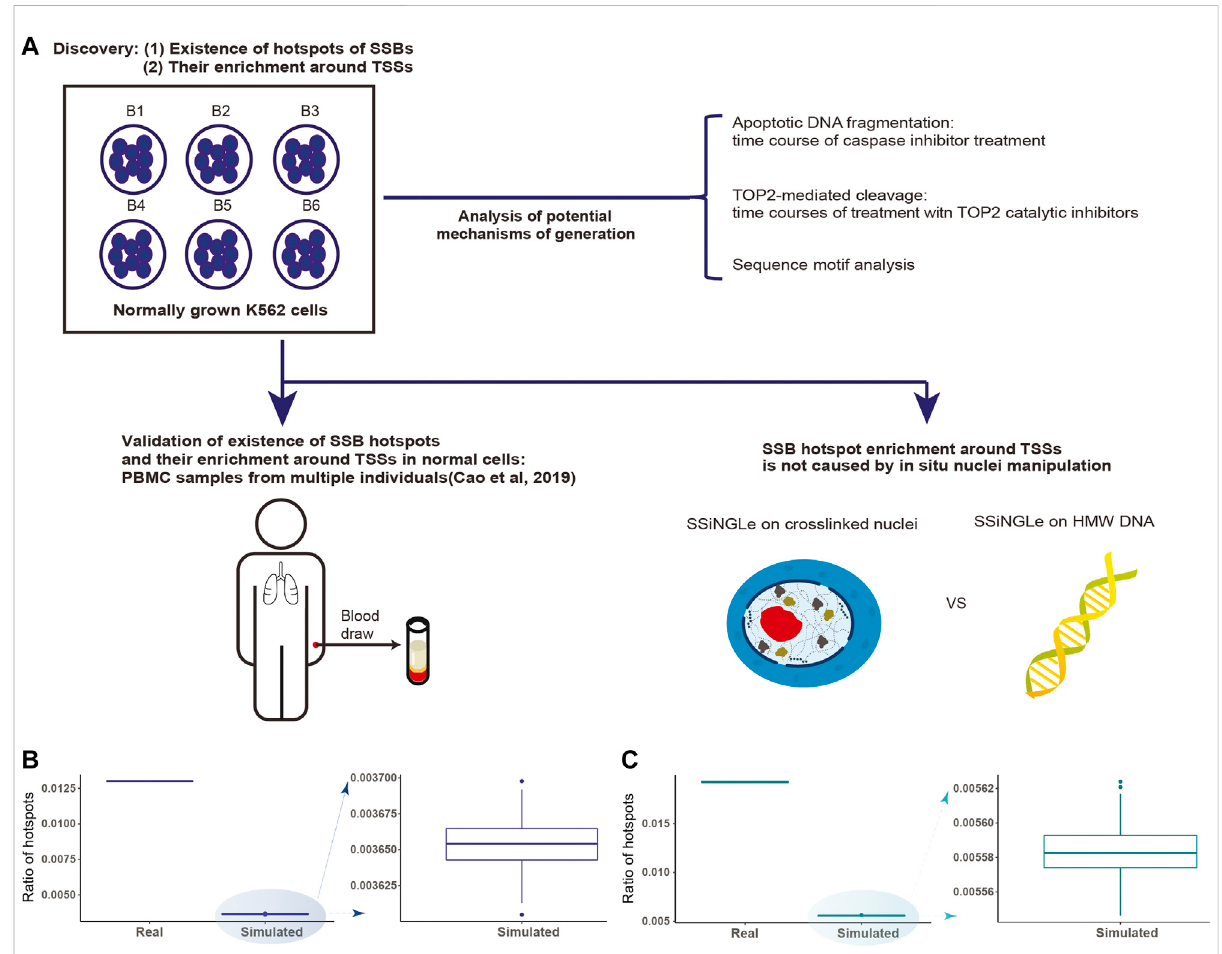
FIGURE 1 Discovery and analysisof SSB hotspots. (A) Schematics illustrating thediscovery and characterizationof SSB hotspots performed inthis work. A hotspot had to be found in at least 2 independent biological samples represented either by different batches of cells (B1-B6 for K562) or PBMCs extracted from 66 individuals. (B,C) Discovery of SSB hotspots in K562 and PBMCs. The fractions of hotspots in the genome (Y-axes) for the real and simulated data (X-axes) from (B) K562 and (C) PBMCs are